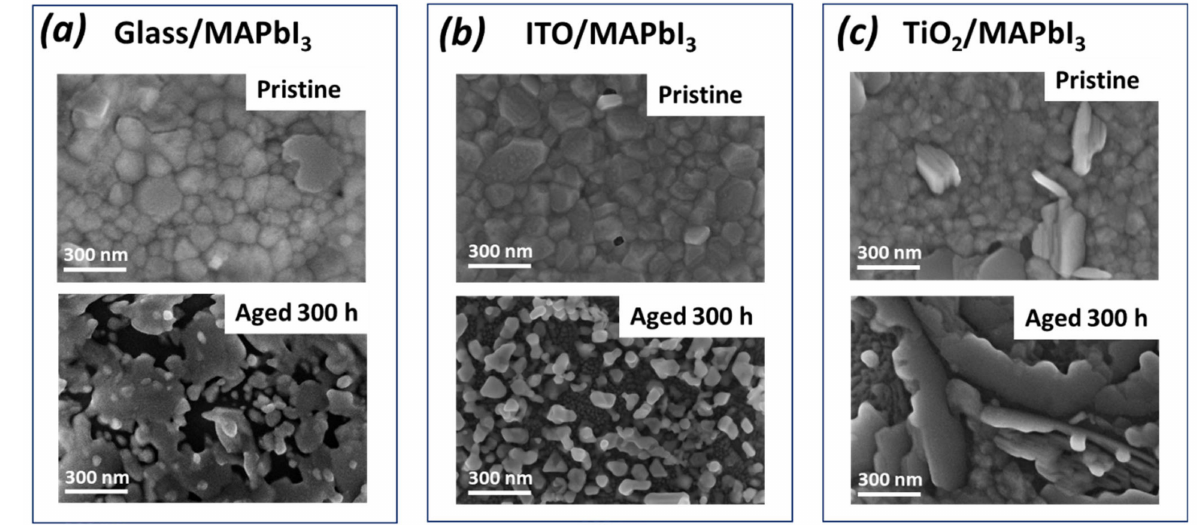
Figure 1. SEM images of MAPbI 3 films grown on ( a ) glass, ( b ) ITO, and ( c ) TiO 2 substrates before and after 300 h of light soaking.